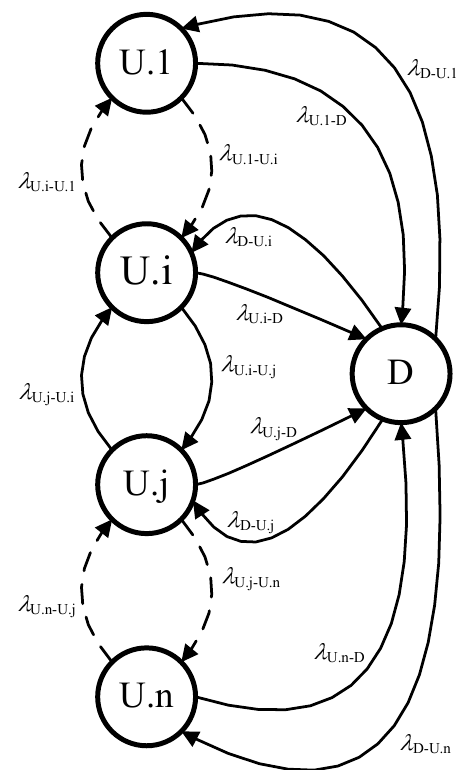
Figure 2. N + 1-state reliability model of a renewable generation system. U.i is an up unit state (normal operation) with i -th of n level of energy carrier {1, . . . , i , j , . . . , n } and D is a down unit state (failure).